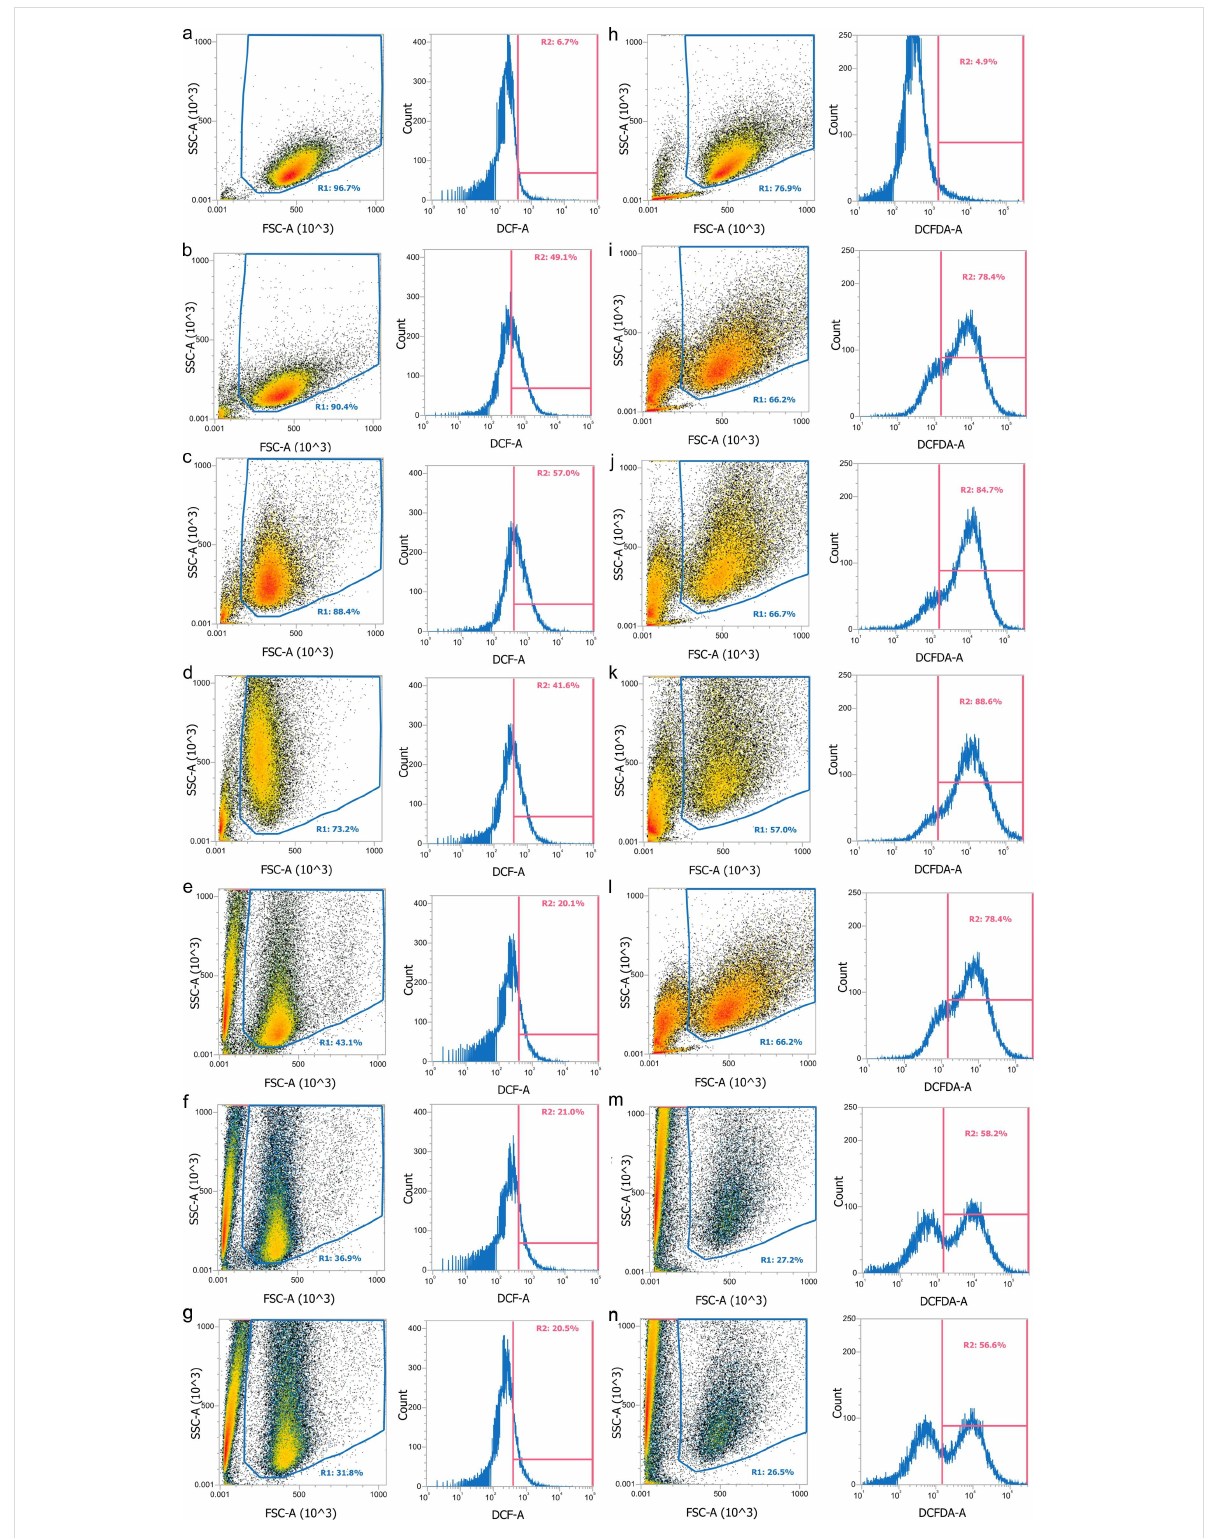
Figure 6: Representative antioxidant activity of the phenolic compound-modified particles in (a–g) L-929 and (h–n) LN-229 cells. The cells were incu- bated with (c, j) γ -Fe 2 O 3 , (d, k) γ -Fe 2 O 3 @Hep, (e, l) γ -Fe 2 O 3 @Hep-CS-G, (f, m) γ -Fe 2 O 3 @Hep-CS-H, and (g, n) γ -Fe 2 O 3 @Hep-CS-P particles for 3 h, followed by 30 min incubation with 2 mM H 2 O 2 (b–g, i–n) prior to analysis using flow cytometry. (a, h) Only cells without and (b, i) with H 2 O 2 treat-